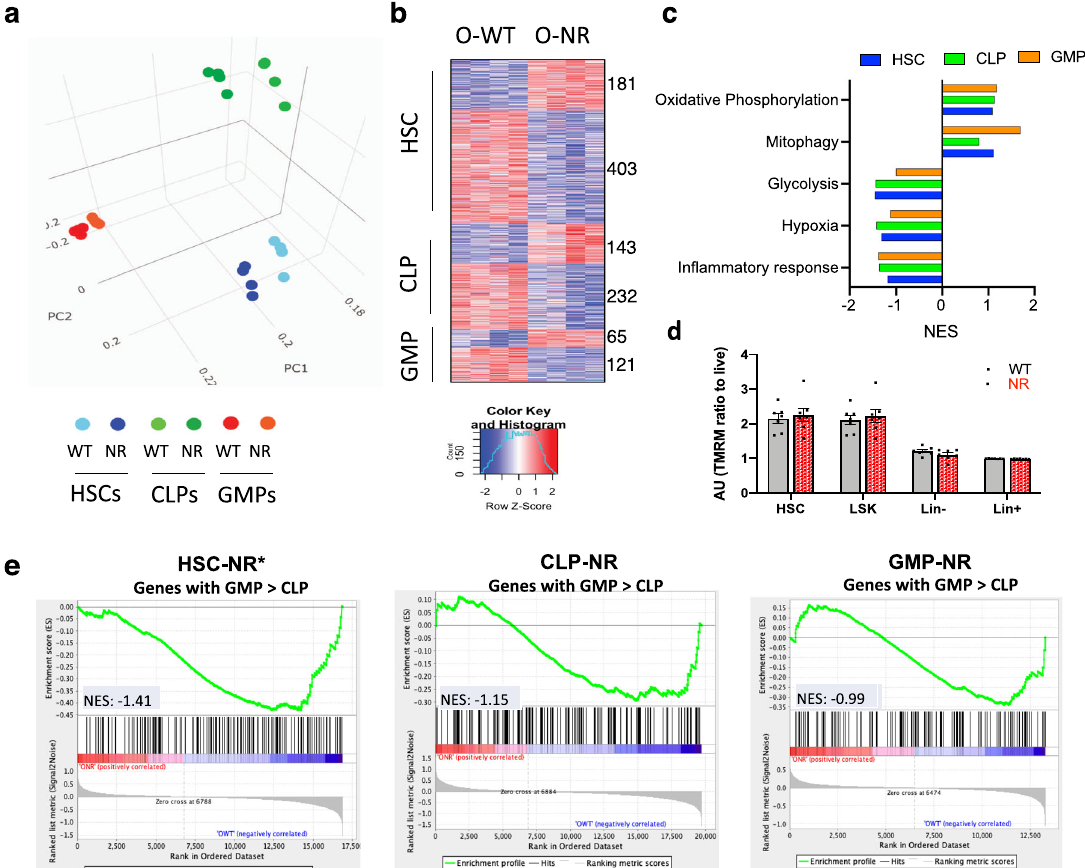
Fig. 4 NR supplementation leads to transcriptional alteration in aged HSCs, CLPs, and GMPs. a PCA analysis of total RNA-seq transcripts from old WT and NR-treated HSCs (Blue), CLPs (Green), and GMPs (Red). b Heatmap analysis of differentially expressed genes in HSCs, CLPs, and GMPs (O-WT vs O-NR) determined using the following thresholds: expression levels CPM > 3, and p value < 0.01. c Normalized enrichment scores (NES) for gene sets comparing NR and untreated cells. d Quanti fi cation of ΔΨ m in aged bone marrow populations after NR (with verapamil). e Gene set enrichment analysis (GSEA) for genes belonging GSE37301_CLP_VS_GMP_Down show decreased expression after NR supplementation in all HSC, CLP, and GMP